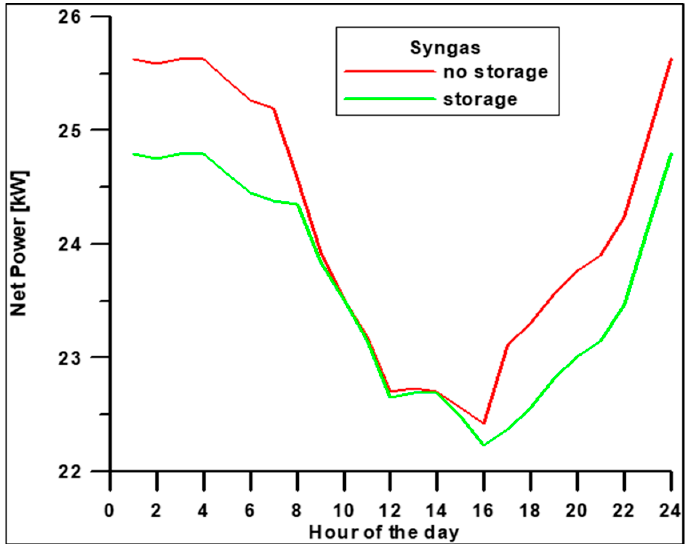
Figure 6. Net power versus day hours (Syngas fuel).